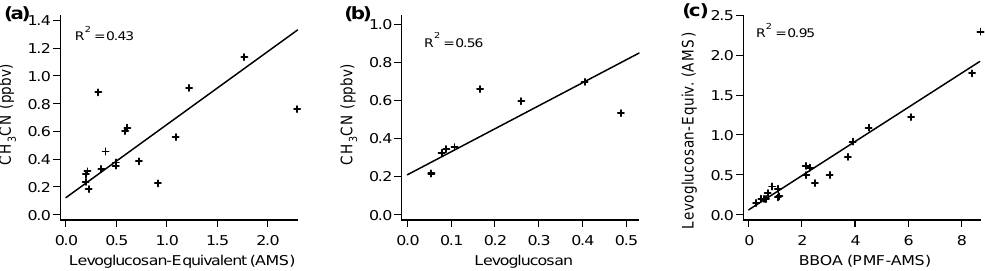
versus PIXE total 14-24 , 1